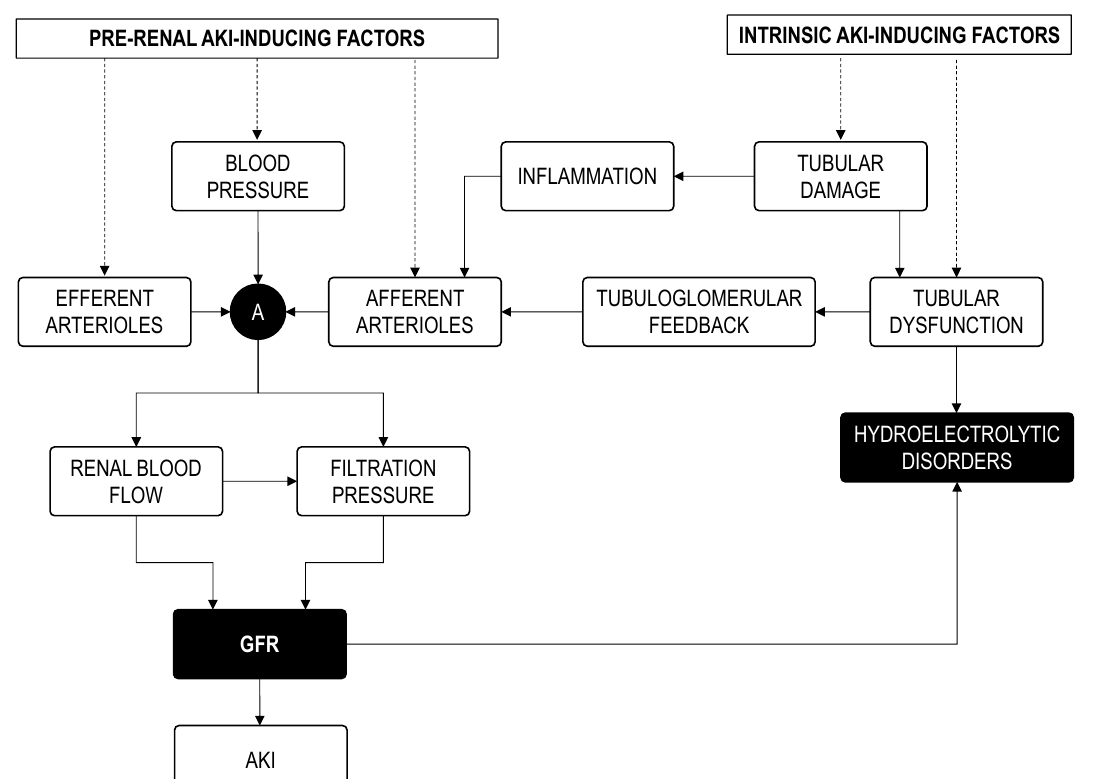
Figure 5. Simplified depiction of the pathophysiological scenario explaining the confluence of pre- renal AKI-inducing mechanisms and intrinsic AKI-inducing mechanisms at reducing glomerular filtration rate (GFR). A, autoregulation mechanisms. AKI, acute kidney injury.